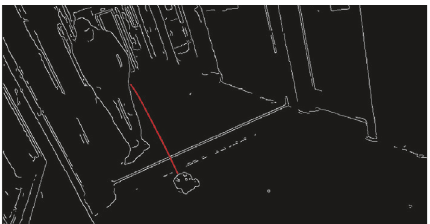
Figure 29: Trajectory path